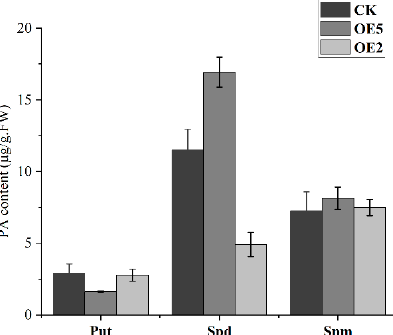
Figure 10. PA content of Arabidopsis leaves overexpressing PavCuAO4.